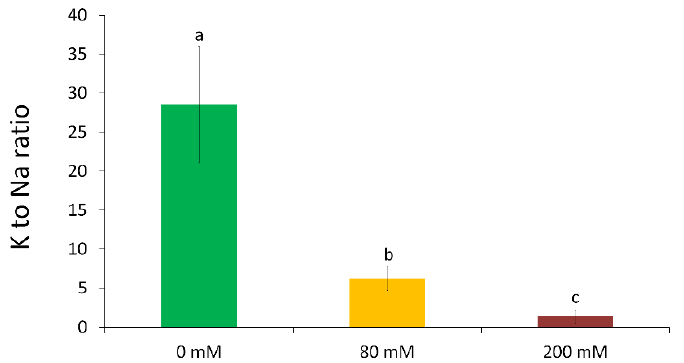
Figure 6. The K to Na ratio in the first fully developed leaves of Arundo donax after 1 month of alkaline salt treatment. Error bars represent SD values. To compare the differences, one-way ANOVA was performed on each dataset with Tukey’s post-hoc test on the treatments ( p < 0.05). Different lowercase letters indicate significantly different groups.